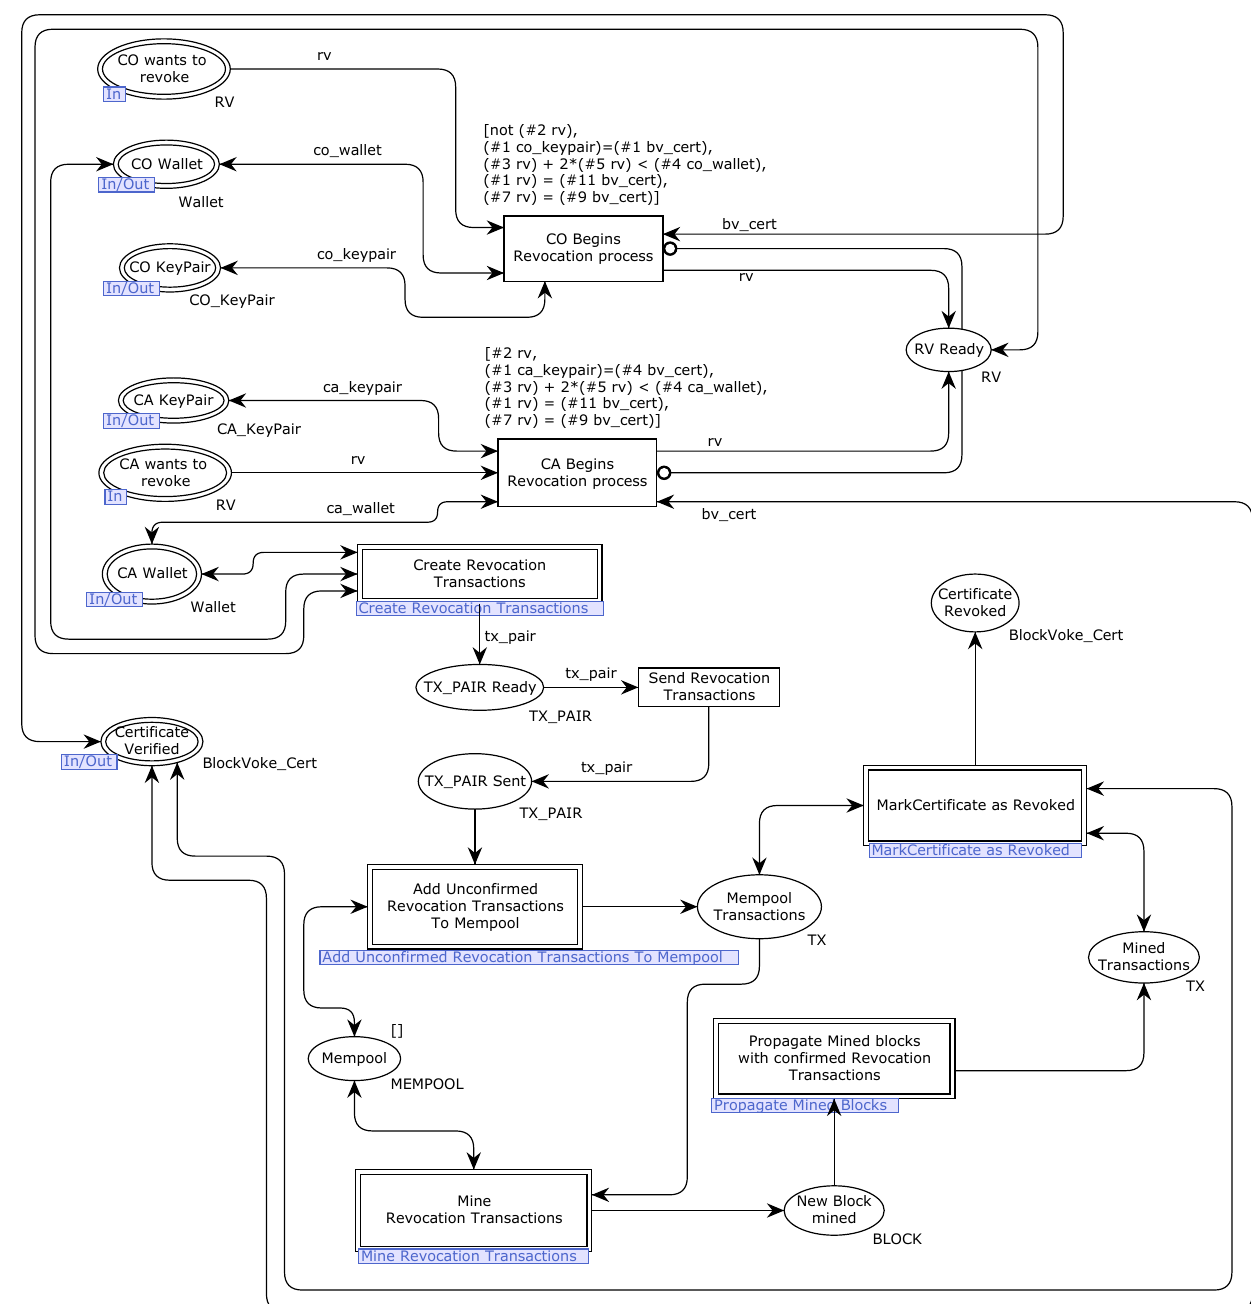
Figure 10. ‘Revoke Certificate‘ sub-module of the BlockVoke CPN